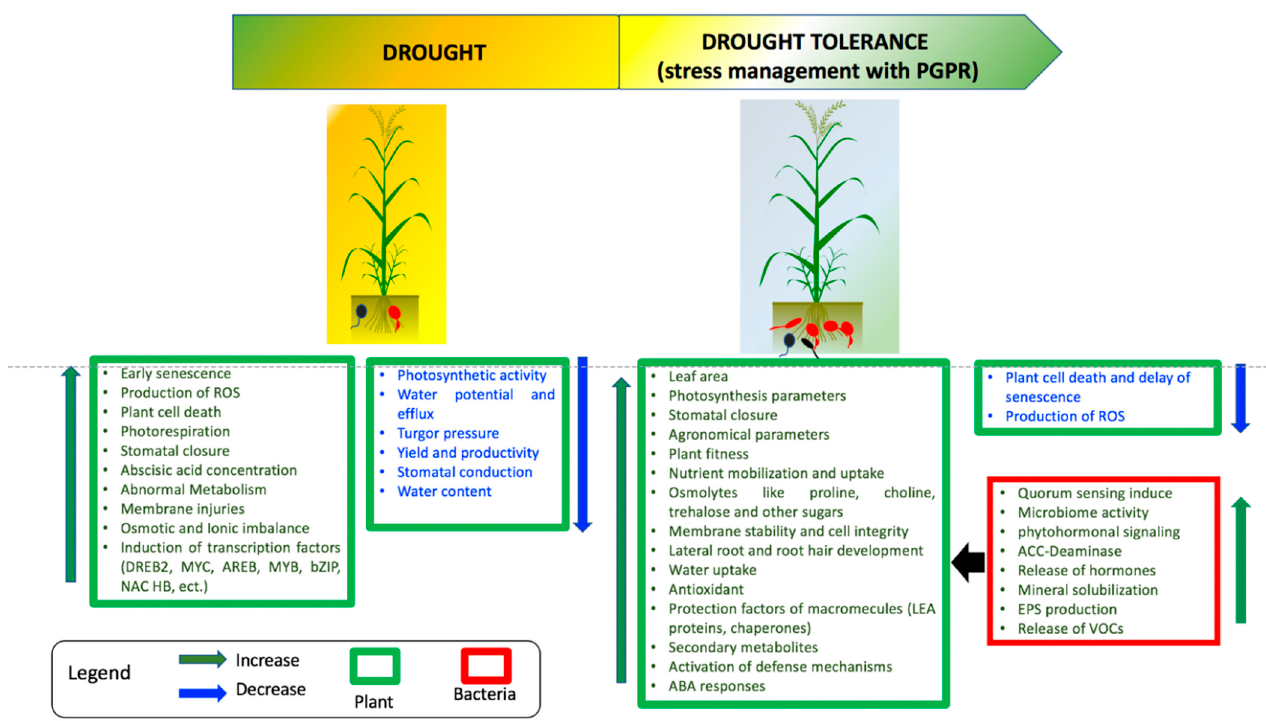
Figure 6. Events triggered in plant by the drought stress and mechanisms used by PGPR to alleviate this stress.